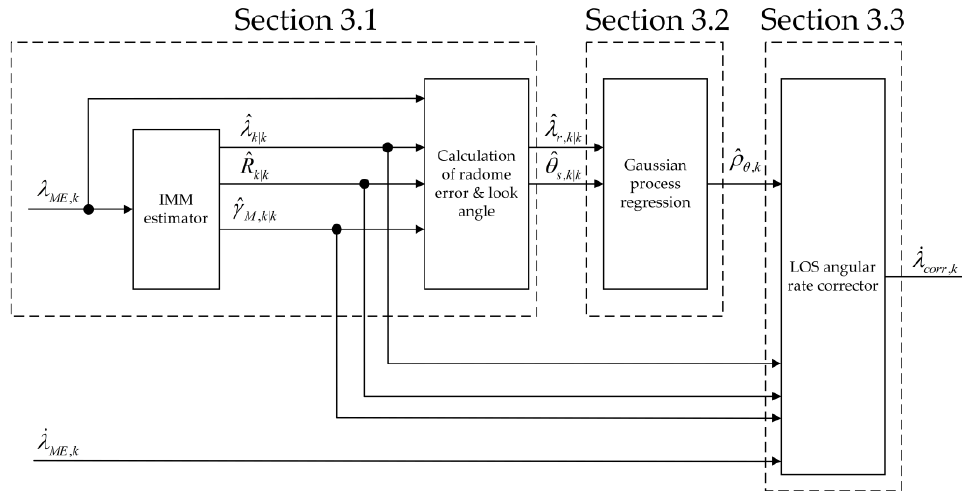
Figure 7. A block diagram of the proposed LOS angular rate corrector. Algorithm 1 : Pseudo code for the proposed LOS angular rate corrector at the th k time